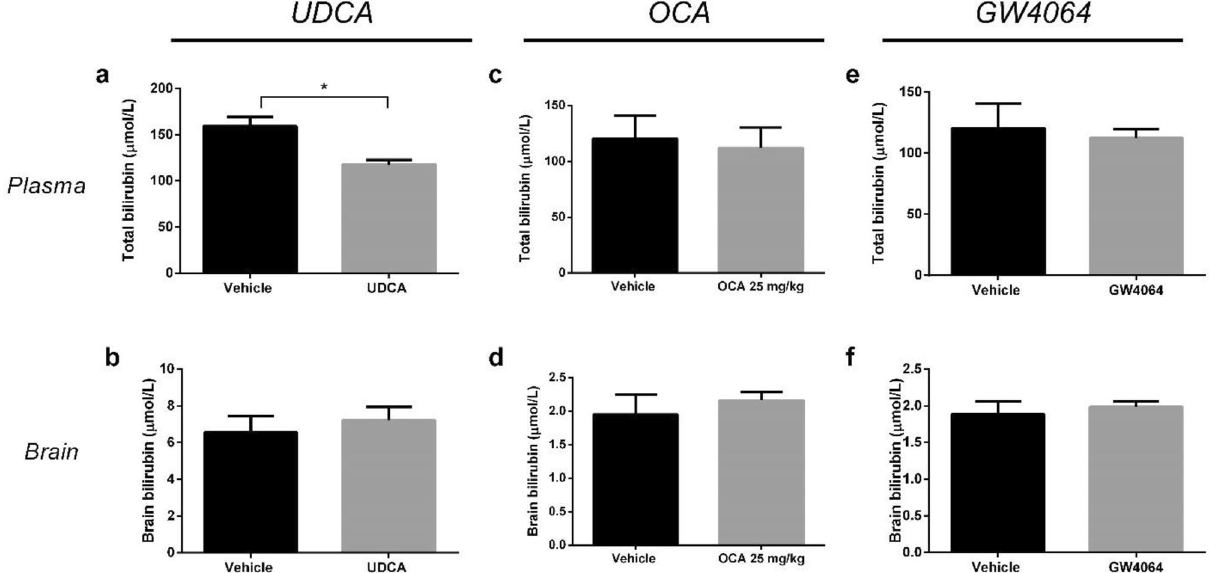
Figure 5. Effect of UDCA, OCA, and GW4064 on plasma and brain bilirubin in neonatal Gunn rats. Effect of ( a , b ) UDCA (250 mg/kg/day) (n = 6); ( c , d ) OCA (25 mg/kg/day) (n = 8), and ( e , f ) GW4064 (50 mg/kg/day) (n = 6) on total bilirubin levels in plasma and